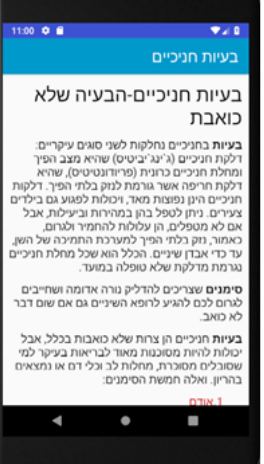
Figure 13. Tutorial screen for the patient: periodontal